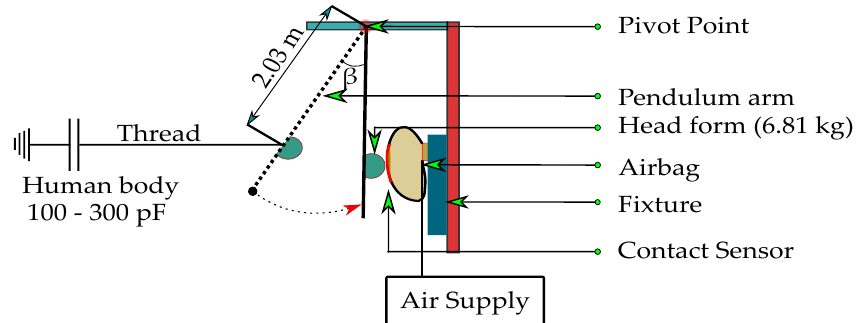
Figure 8. Low-impact velocity pendulum test